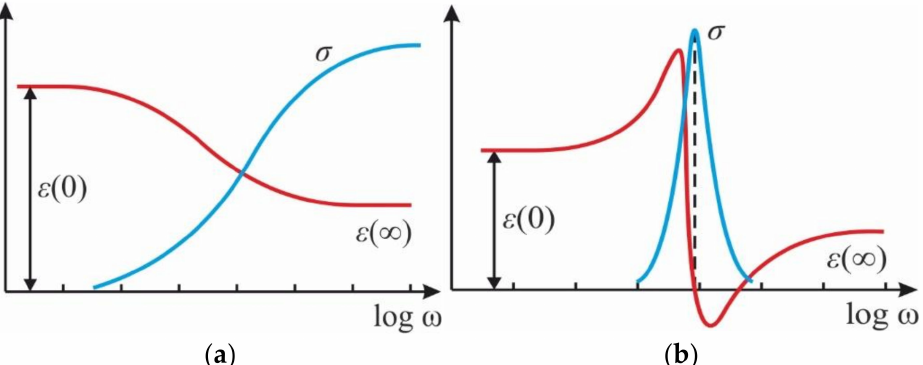
Figure 4. A comparison of the permittivity and effective conductivity frequency dependence of two main models describing permittivity dispersion: ( a ) relaxation; ( b )